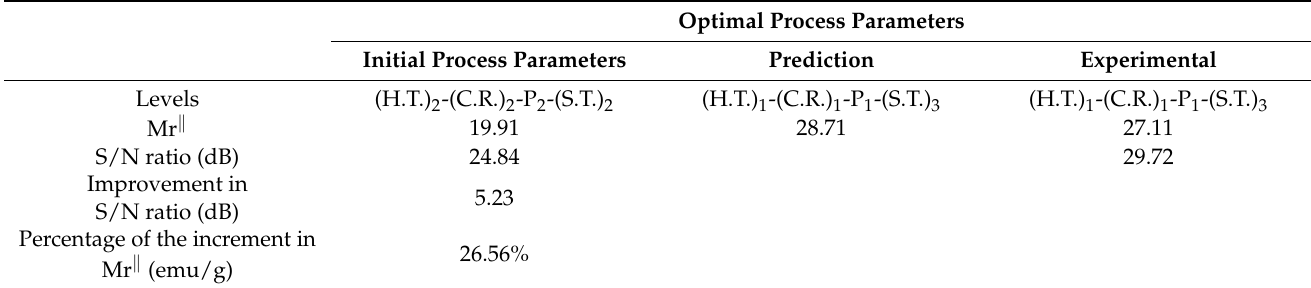
Table 7. Confirmation test results for Mr (cid:107) .